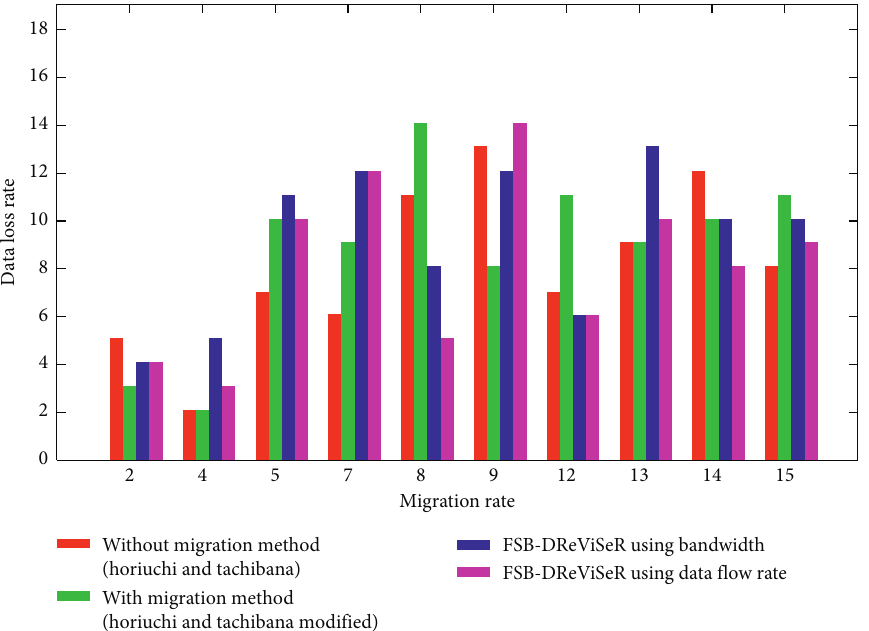
Figure 15: Data loss rate versus migration rate for a 60-node